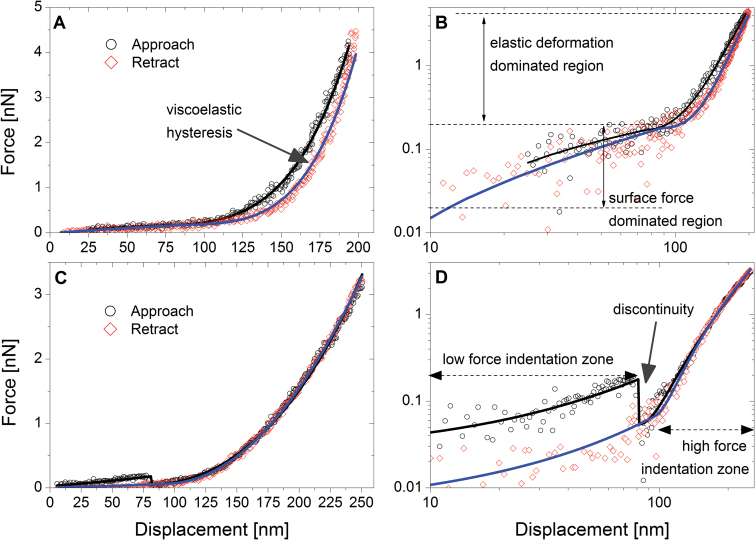
Typical force–indentation curves (FICs) for L. multiflorum SCCs (A and C) and their corresponding versions in log–log scale (B and D). The majority of FICs were characterized by three resistors: a surface force, linear deformation (elastic membrane), and a thin elastic film. The elastic membrane deformation occurred concomitantly with the other resistors, generating a two-regime response. In both cases, discontinuities associated with penetration of the tip into the voids of the cell wall mesh are present. (This figure is available in colour at JXB online.)